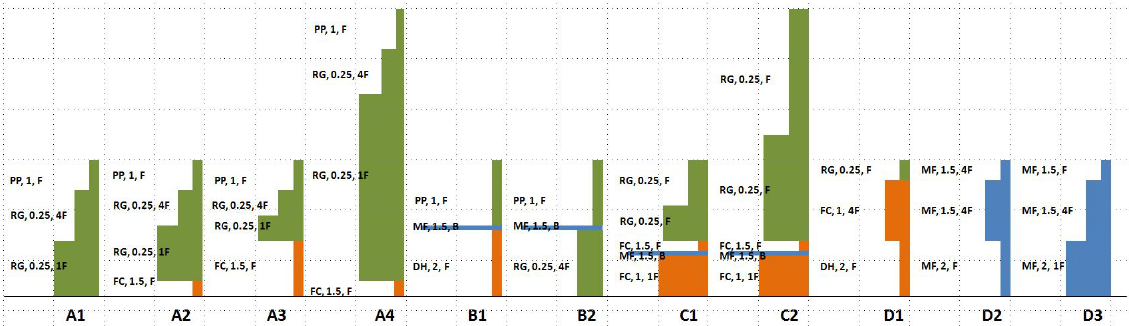
Fig. 3. Simplified snow profiles. The hand hardness profile is shown with the main grain type (colour) indicated. Layer properties (text) are given for each layer in the following order: grain type, grain size (mm), and hand hardness. Abbreviations are according to Fierz et al. (2009).